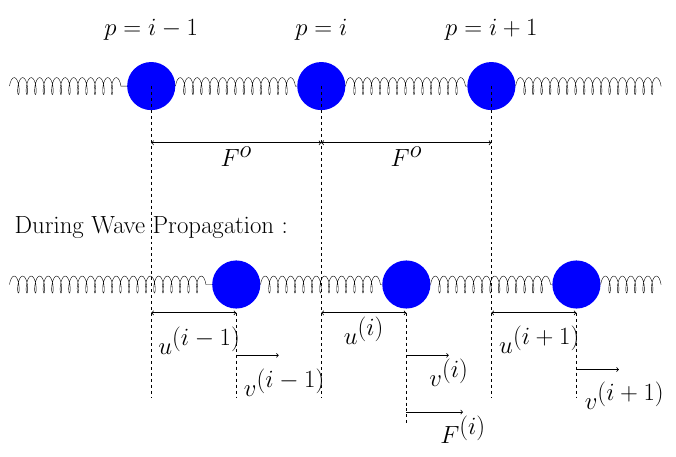
Figure A1. Particle chain for a simple triplet case to show the energy